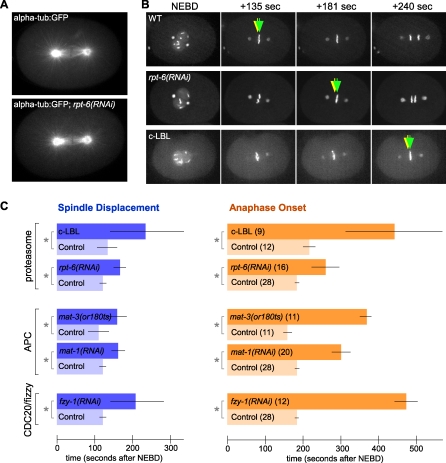
Proteasome Function, the APC, and Cdc20/Fizzy Are Required for Timely Spindle Displacement(A) Images from films of embryos expressing alpha-tubulin:GFP in control or rpt-6(RNAi) treated embryos, showing that RNAi targeting the proteasome component RPT-6 does not grossly disrupt spindle morphology. Using c-LβL to target proteasome activity produced similar results (unpublished data).(B) Images of embryos monitored for spindle displacement and anaphase onset, showing that treatments targeting the proteasome delay spindle displacement. Time is indicated in seconds after NEBD, and the chromatin position (green arrow) and 50% embryo length (yellow arrow) are indicated at the timepoint at which spindle displacement was first detectable for each case.(C) Quantitative analysis of the time between NEBD and either spindle displacement or anaphase onset, showing that disrupting proteasome function, the APC, or Cdc20/Fizzy results in a delay in spindle displacement. Components targeted are indicated at left, with specific treatments used to do so indicated on the data bars. Controls include the following, matched to each treatment: laser-permeabilized embryos in DMSO (for comparison to c-LβL), embryos in which the temperature was raised to 25 °C as in temperature-shift experiments (for comparison to mat-3(or180)), and embryos that were raised and imaged at 20 °C (for comparison to all other backgrounds in this figure). mat-1(RNAi) embryos were examined 3–6 h after injection. Treatments disrupting the APC or FZY-1 appear to specifically lengthen the times to anaphase onset and spindle displacement, and not to affect cell cycle timing more generally, as we found that they did not lengthen the interval from anaphase to cytokinesis (n = 11 embryos for mat-1(RNAi), n = 7 embryos for mat-3(or180), n = 7 embryos for fzy-1(RNAi), n = 8 embryos for wild-type temperature-shifted control, n = 10 embryos for 25 °C wild-type control, n = 19 embryos for room-temperature wild-type control) nor shorten or lengthen the interval from pronuclear meeting to NEBD (n = 15 embryos for wild-type, n = 6 embryos for mat-1(RNAi)). The delay in anaphase onset after c-LβL treatment is less than that found previously [9]; here, we have used a lower concentration of c-LβL, which was sufficient to delay anaphase, and we have measured anaphase more precisely by observing histone H2B:GFP. Error bars represent the 95% confidence intervals for significance, and asterisks represent statistical significance at p < 0.05. Number of cases analyzed for each experiment is indicated in parentheses on the anaphase onset bars. For statistical values, see Methods.